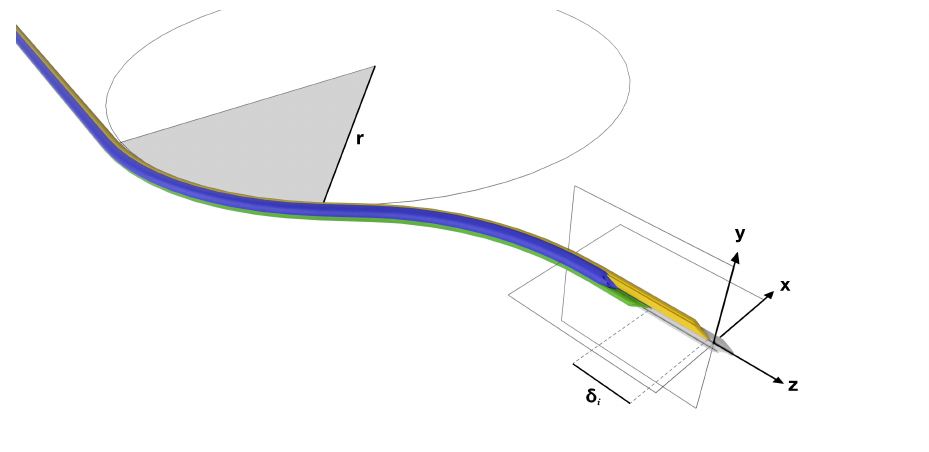
Figure 2. Four-segment PBN showing the radius of curvature, r, an offset between two segments, δ i , and the catheter tip